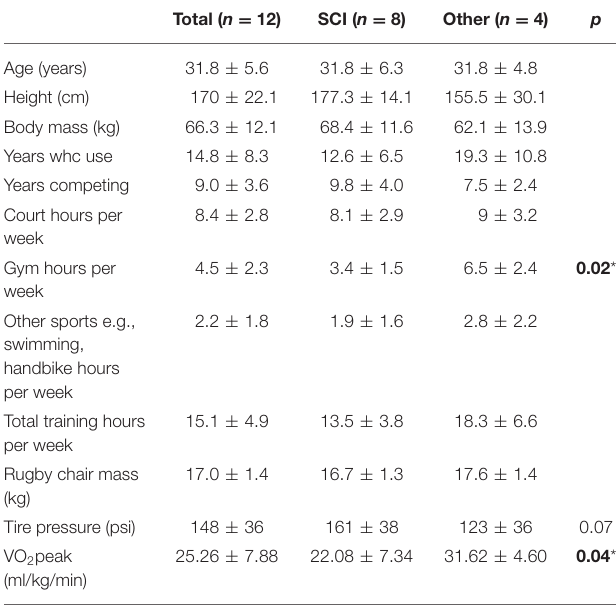
TABLE 1 | Characteristics of participants and their wheelchair (whc) stratified by